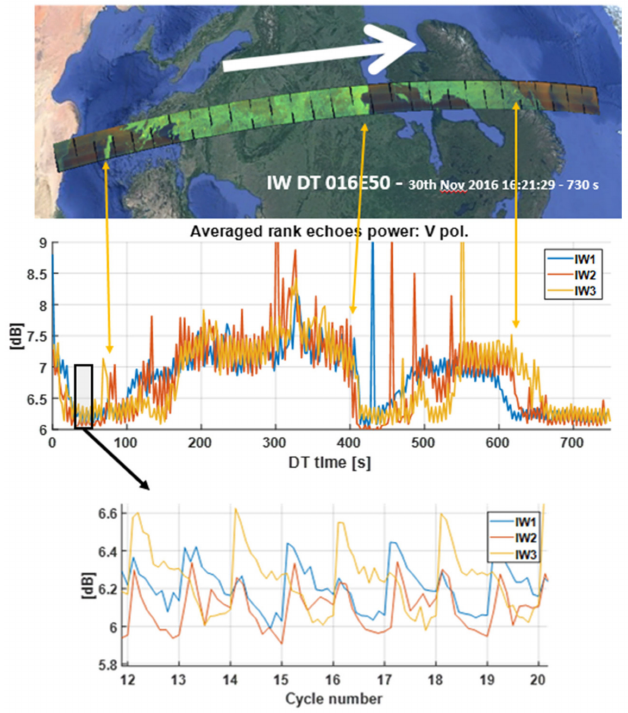
Figure 2. A 730-s long data-take, upper panel, has been used to validate the measure of noise power from rank echoes, mid panel. Notice the changes in the mean power occurring near see/land transitions, as expected from the change in the albedo. A zoom of the power profile, lower panel, shows a saw-tooth behavior with two cycle’s periodicity, following the calibration in Table